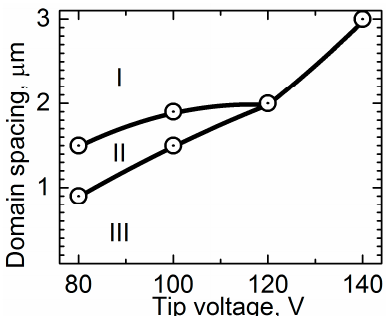
Figure 4. Phase diagram of the switching behavior (regimes of the domain size distribution in the array) as a function of bias (tip voltage) and the spacing between the points of bias application (domain spacing). Regions of various regimes are shown: (I) uniform ; (II) intermittent quasiperiodic ; (III) chaotic .